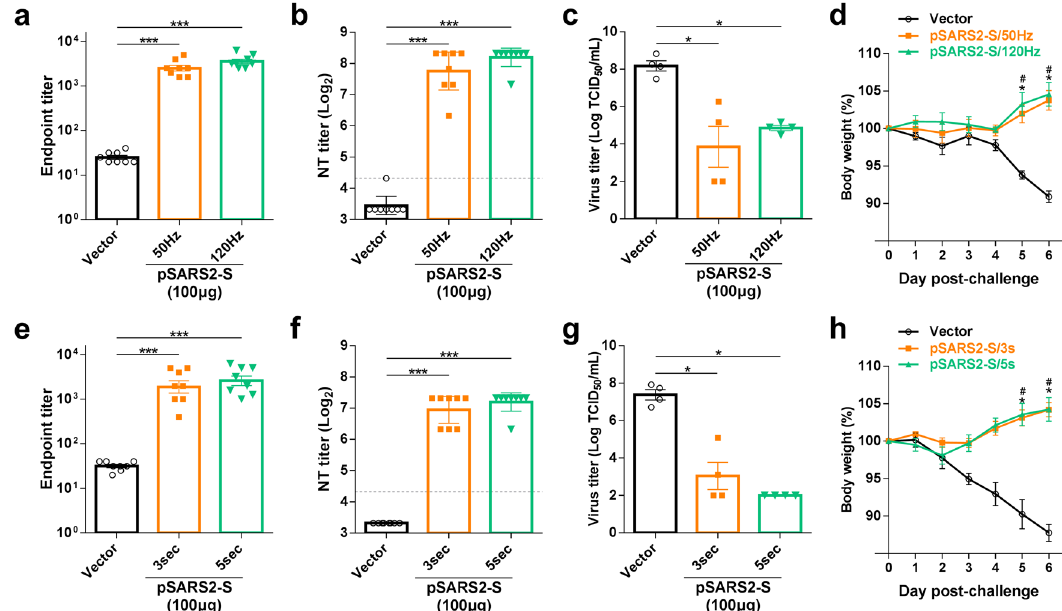
Fig. 4 The effect of stimulation frequency and time on SARS-CoV-2-infected hamsters. a – d Syrian hamsters ( n = 8 per group) were intramuscularly immunized three times at a 2-week interval with 100 μ g of vector control or pSARS2-S, followed by electrostimulation at 40 Vpp with a frequency of 50 or 120 Hz for 10 s. e – h Hamsters ( n = 8 per group) received 40 Vpp/120 Hz electrostimulation for 3 or 5 s following DNA injection, and three-dose vaccination regimen was described as above. Serum samples obtained at week 6 after the fi rst immunization were used in this experiment. a , e Endpoint titers of serum IgG speci fi c to spike protein were evaluated by ELISA. b , f Serum neutralizing activity against wild-type SARS-CoV-2 was evaluated by neutralization assay. The dashed line indicates the initial fold dilution of serum samples. At 3 weeks after the fi nal immunization, Syrian hamsters were intranasally challenged with 10 5 TCID 50 SARS-CoV-2. c , g Viral titers in the lungs of SARS-CoV-2-infected hamsters at 3 days postchallenge were determined by TCID 50 assay. d , h Body weight change (%) of the hamsters was recorded every day after SARS-CoV-2 challenge. Neutralization titers are expressed as the geometric mean with a 95% con fi dence interval, and other data are presented as the mean ± SEM. * p < 0.05, *** p < 0.001 by the Mann – Whitney